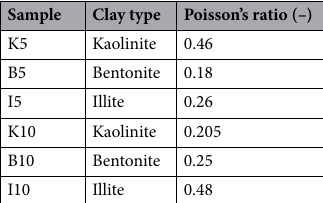
Table 6. Poisson’s ratio of samples.